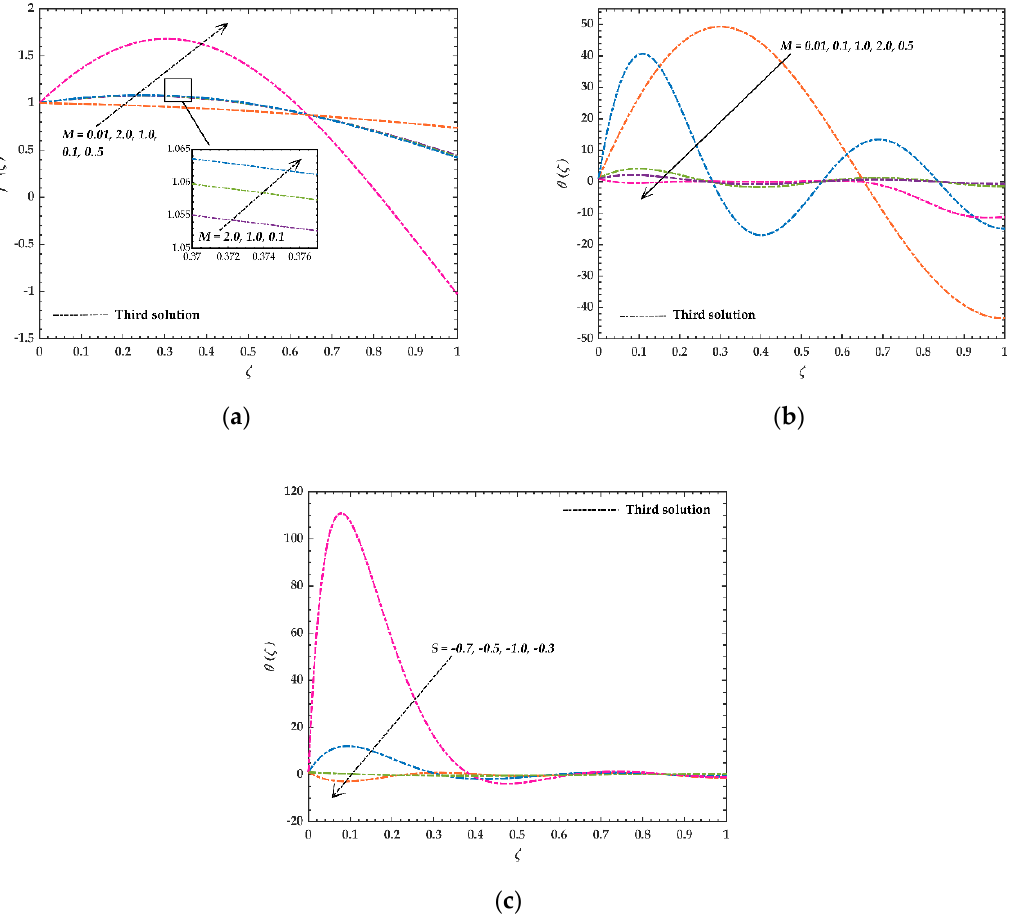
Figure 8. ( a ) Velocity profiles, f (cid:48) ( ζ ) of the third solution when Pr = 30, We = 0.2, n = 0.6, S = − 0.3 and σ = 1.2 as M varies; ( b ) Temperature profiles, θ ( ζ ) of the third solution when Pr = 30, We = 0.2, n = 0.6, S = − 0.3 and σ = 1.2 as M varies; ( c ) Temperature profiles, θ ( ζ ) of the third solution when Pr = 30, We = 0.2, n = 0.6, M = 2 and σ = 1.2 as S